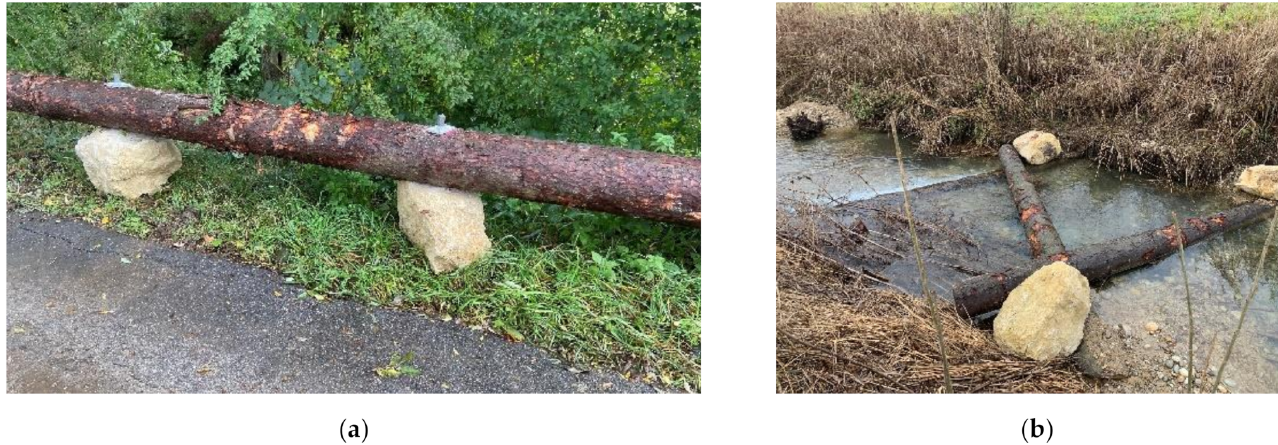
Figure 12. ( a ) Anchoring of boulders to an LW-log; Witibach stream; Photo: V. Neuhaus; ( b ) weighted LWS with locally available boulders; Witibach stream; Photo: V.